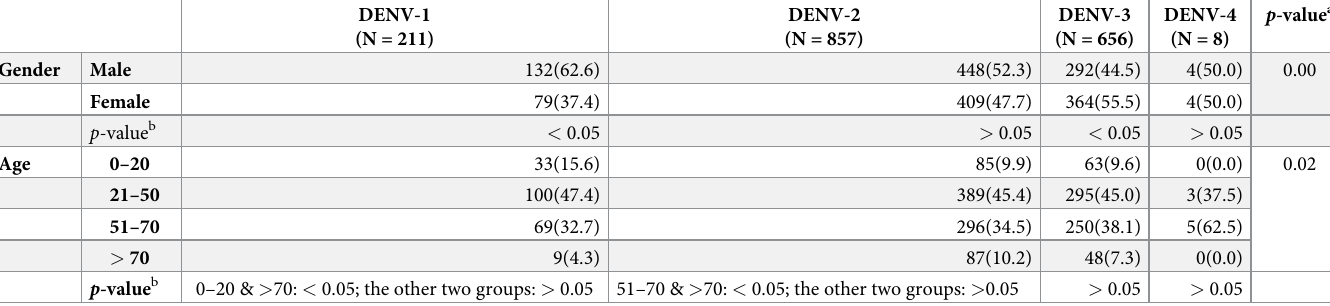
Table 2. Comparison of four different dengue viral serotypes with gender and age of dengue-infected patients.